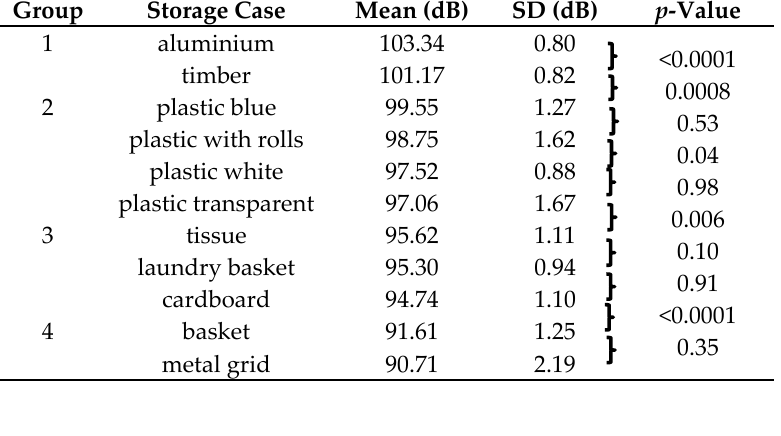
Table 1. Descriptive and statistical data of L AFmax noise level measurements when dropping DUPLO toy bricks. Eleven different storage cases are arranged in classes of decreasing order. Statistical significance analyses were performed with one-way ANOVA and following Tukey post hoc test. It was iteratively done for each basket with its adjacent case in the decreasing L AFmax order. Calculation of SD was performed with n = 25 and Bessel’s correction.